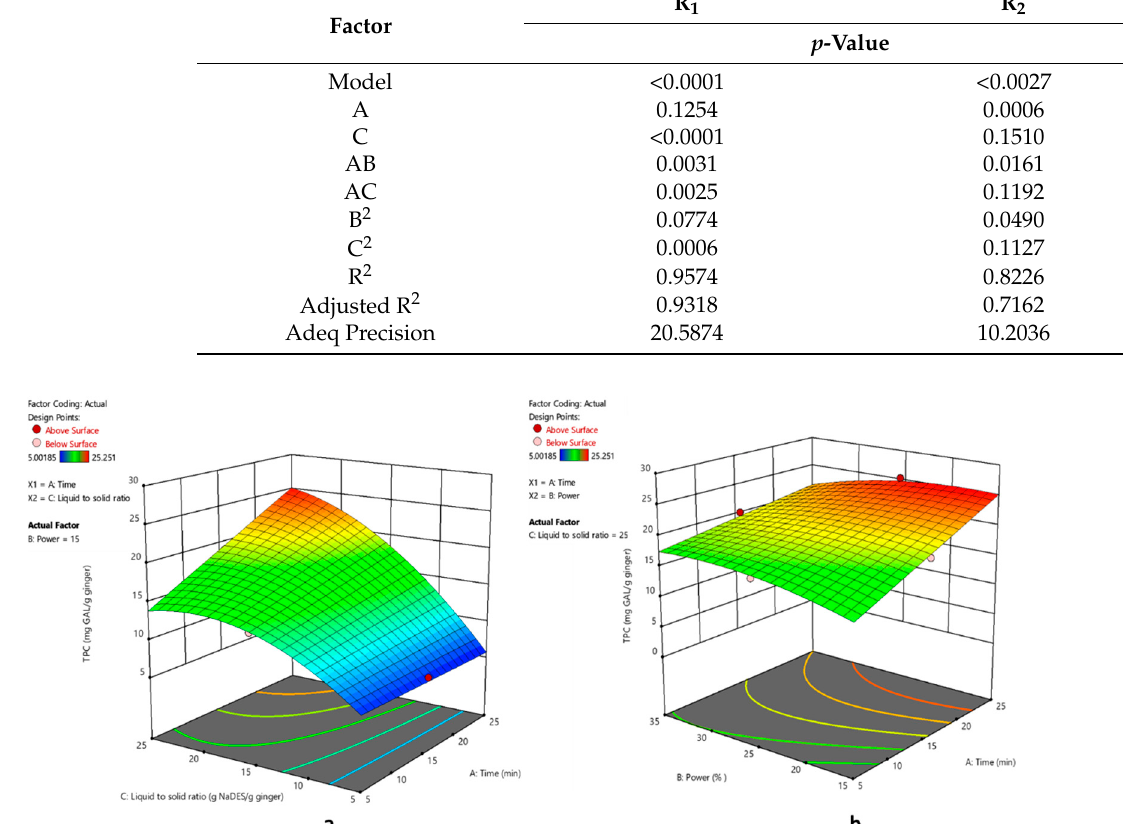
Figure 4. RSM plots for TPC response showing the correlation between TPC and the factors: ( a ) time and NaDES-to-dry ginger ratio, ( b ) time and ultrasound power.